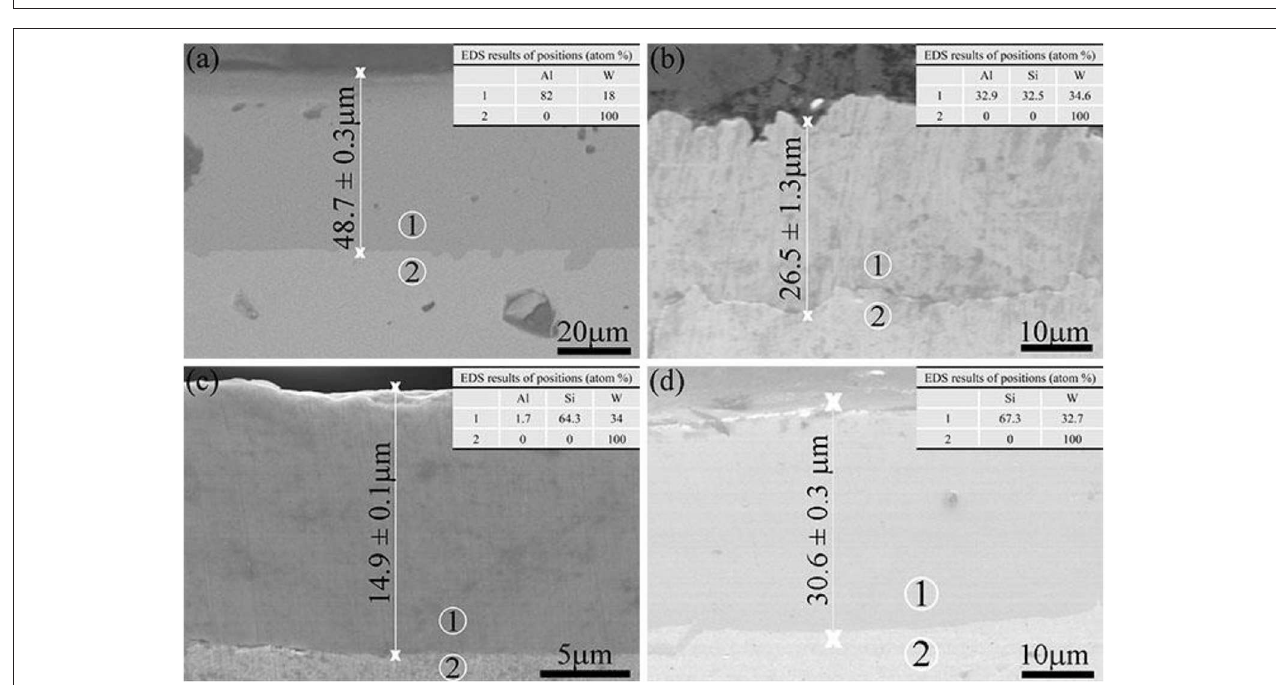
FIGURE 3 | Cross-sectional SEM micrographs of the as-deposited coatings. (a–d) S1–S4.